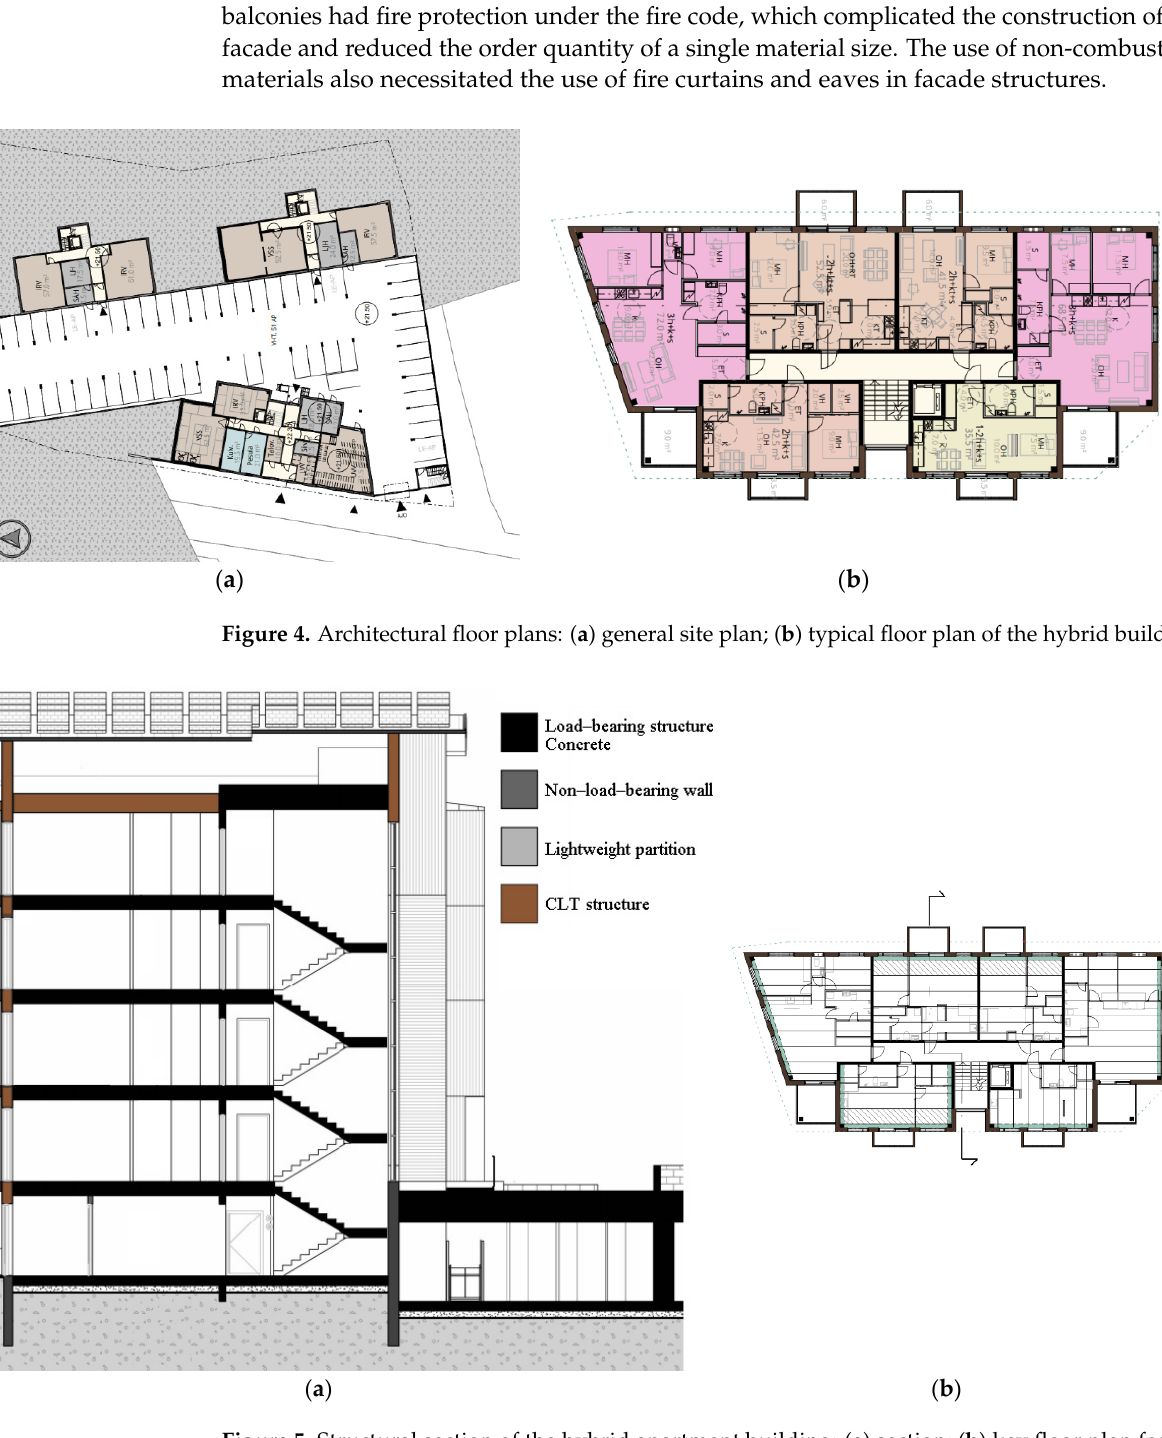
Figure 5. Structural section of the hybrid apartment building: ( a ) section; ( b ) key floor plan for the section.